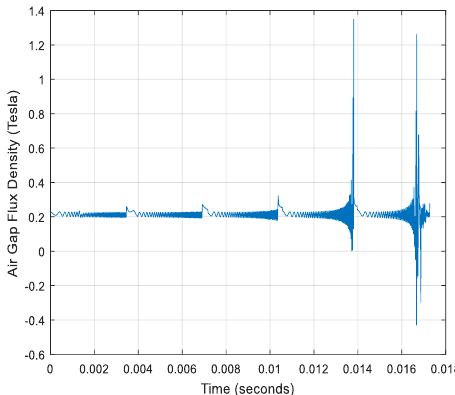
Figure 5. Air gap flux density in time domain (machine with 10% eccentricity fault).